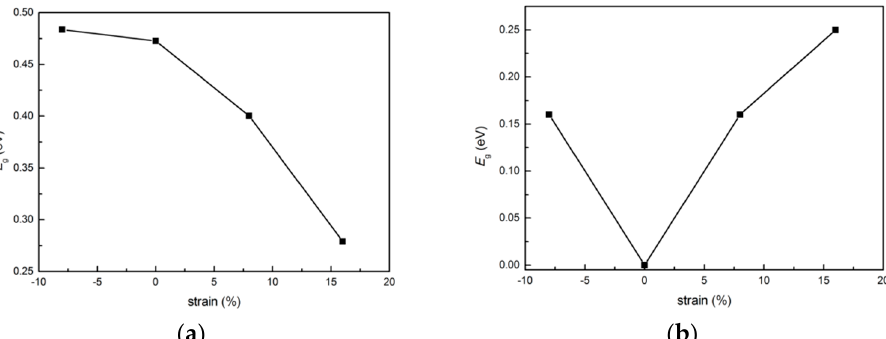
Figure 17. Band gap variation under strain for: ( a ) 7-ac-(MoS 2 ) 3 /(WS 2 ) 3 -NR-sym (left column) and ( b ) 7-ac-(MoS 2 ) 3 /(MoTe 2 ) 3 -NR-sym (right column).